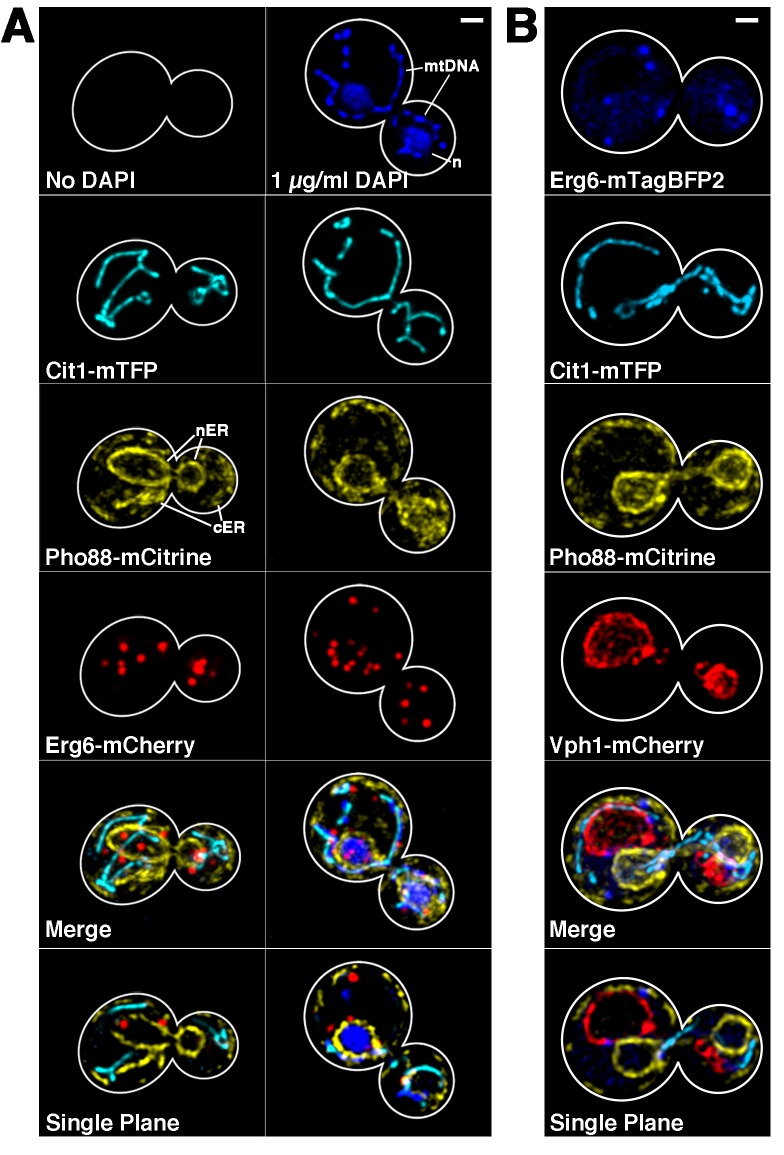
Utilization of mTFP1, mCitrine, mCherry and DAPI for 3- and 4-color, live-cell imaging.A) BY4741 cells expressing Cit1-mTFP1, Pho88-mCitrine, and Erg6-mCh were imaged either untreated (left panels) or after staining with 1 μg/mL DAPI for 10 min (right panel) at 30°C as described in Materials and Methods. B) Images of BY4741 cells expressing Erg6-mTagBFP2, Cit1-mTFP, Pho88-CmCitrine, and Vph1-mCherry. For A-B, Z-series were collected with wide-field microscopy at 0.5 μm intervals throughout the entire cell using a metal-halide lamp and appropriate filters using 216 gain and the following exposure times: 100 ms for Cit1-mTFP1, 200 ms for Pho88-mCitrine, 200 ms for Erg6-mCherry, 100 ms for DAPI, and 400 ms for mTagBFP2. Cell outlines were drawn over phase images. Scale bar = 1 μm. n = nucleus. mtDNA = mitochondrial DNA. nER = nuclear ER. cER = cortical ER.